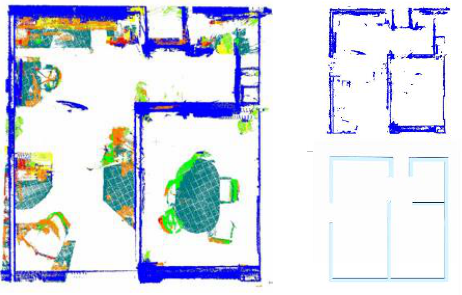
Figure 6. a) full semantic segmentation results from the top view; b) labelled wall points largely delineate the floor plan; c) CAD model digitized from the point cloud for quick